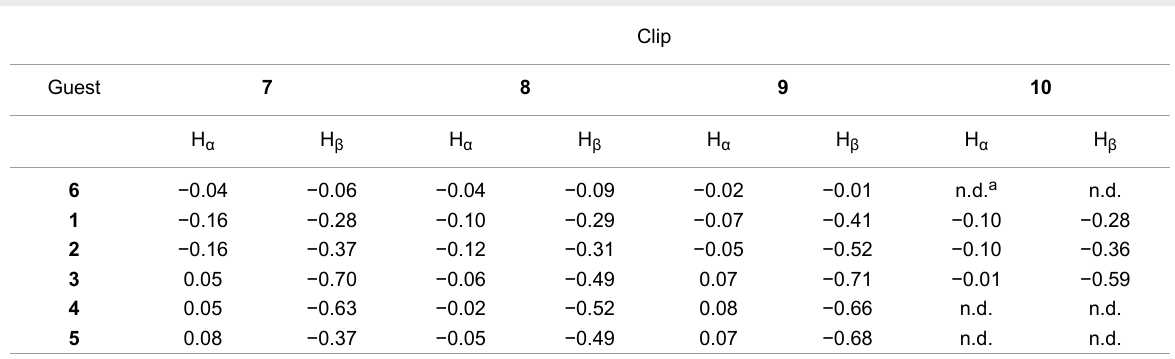
Table 1: Induced chemical shifts ( Δδ ) of aromatic protons of guests 7 – 10 (H α and H β ) in the 1 H NMR spectra of their equimolar mixtures with clips 1 – 6 .